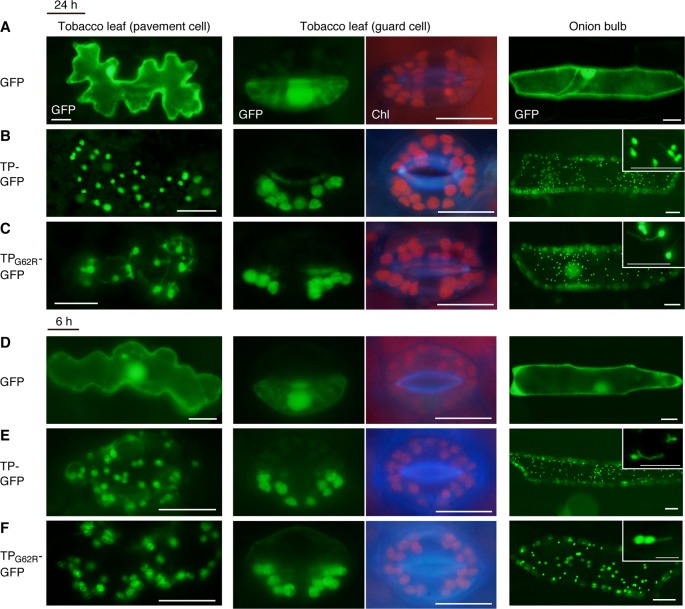
Localization analysis of GFP fused to the mutant transit peptide of PARC6 (TPG62R-GFP). GFP with or without a PARC6 transit peptide (TP) sequence from Col or parc6-5 (TPG62R) was transiently expressed in tobacco and onion cells by particle bombardment. (A–F) Epifluorescence microscopy images of tobacco leaf pavement cells and guard cells and onion epidermal cells at 24 h (A–C) or 6 h (D–F) post-bombardment. GFP fluorescence, chlorophyll autofluorescence (Chl), and merged images are shown. Scale bars: 20 µm (all guard cells and insets); 50 µm (others).